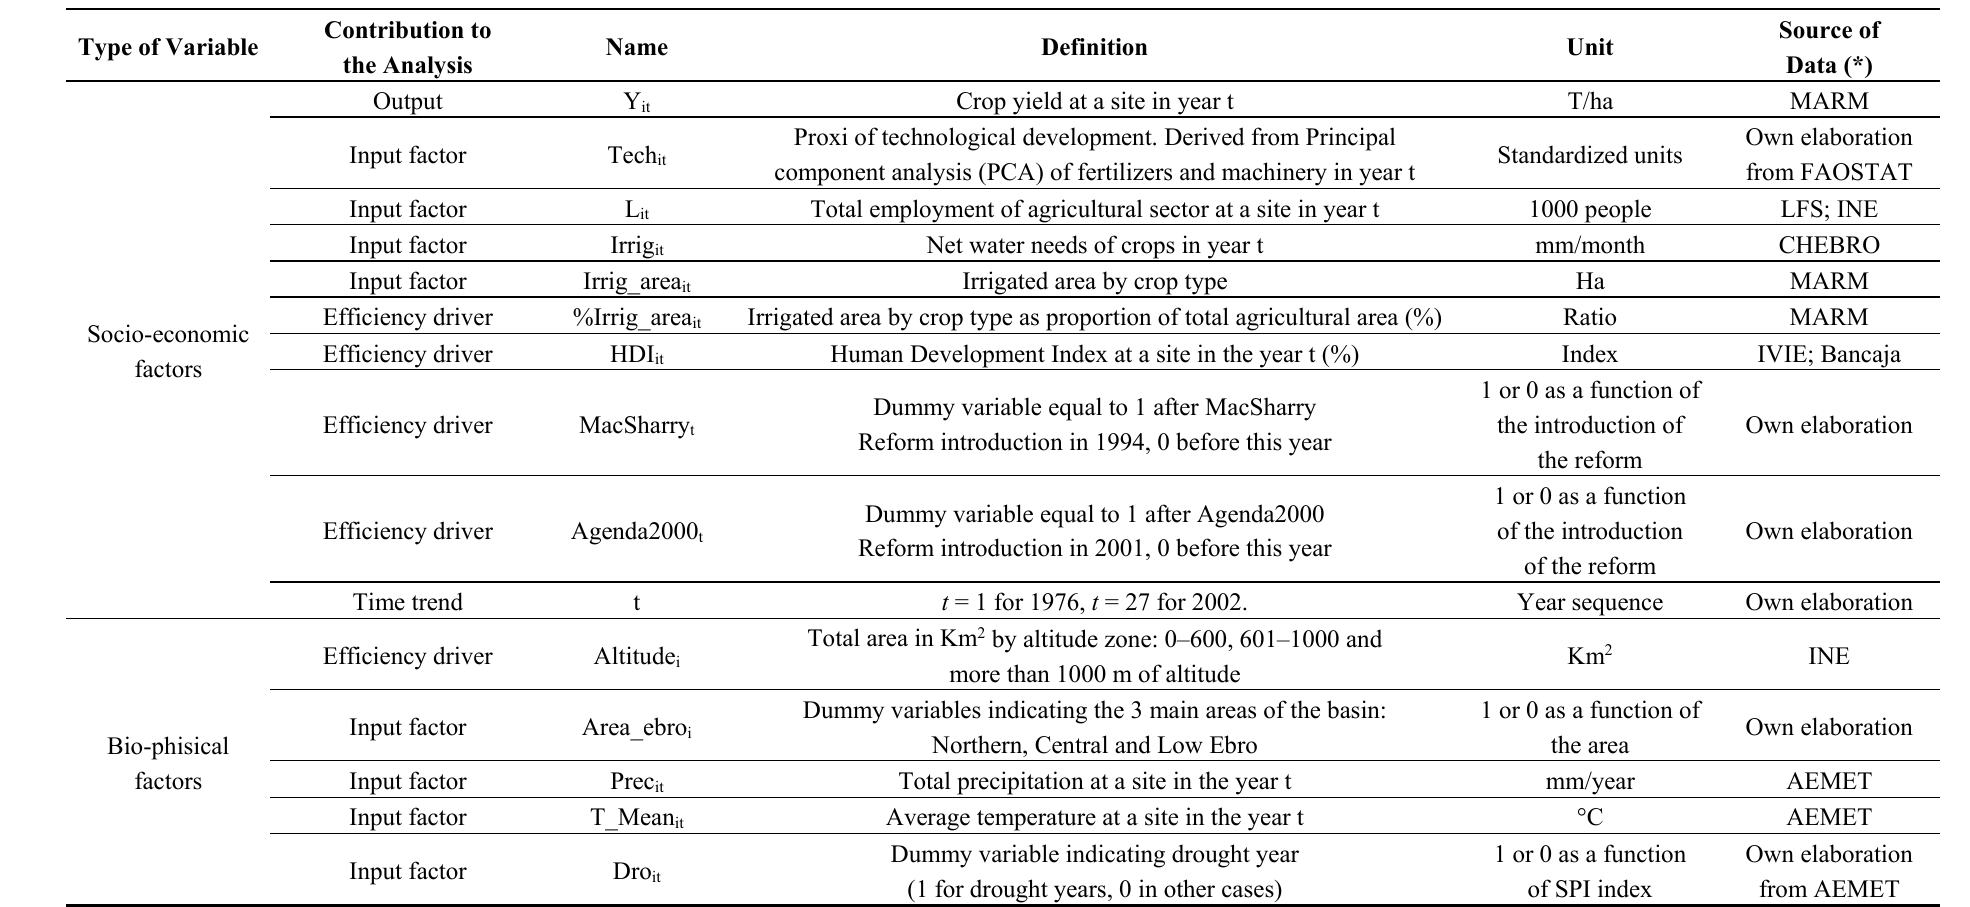
Table 2. Description of